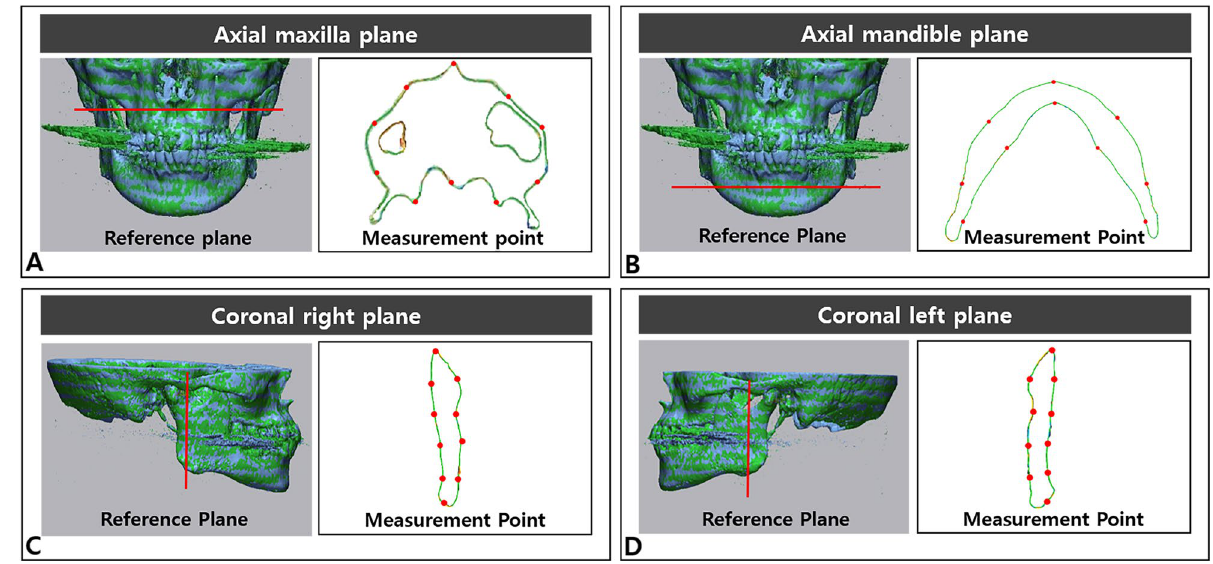
Figure 2. Determination of reference planes and measurement points on superimposed digital models for deviation assessment. The red line indicates a reference plane and the red dot indicates a point of measurement. The anatomical point of each reference plane is as follows. ( A ) A-point, ( B ) right mental foramen, ( C ) the lowest point of the right sigmoid notch, and ( D ) the lowest point of the left sigmoid notch. The starting point for the measurement points is the most superior or anterior point, with subsequent points automatically generated at the same